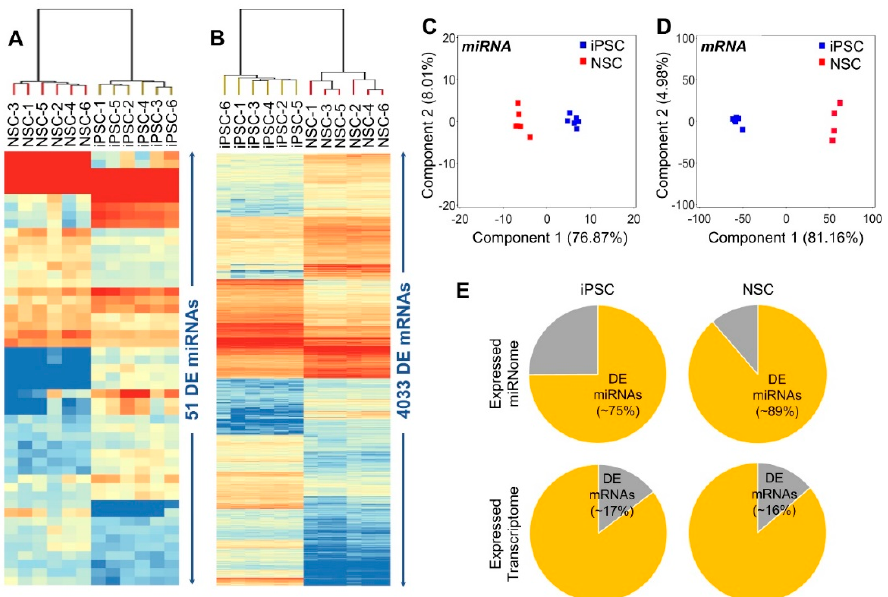
Figure 3. miRNA and mRNA differential expression analysis between iPSCs and their differentiated NSCs. ( A ) Heat map of 51 differentially expressed (DE) miRNAs. ( B ) Heat map of 4033 DE mRNAs. ( C , D ) Principal component analysis (PCA) based on DE miRNAs and DE mRNAs between iPSCs and differentiated NSCs. ( E ) Pie graph showing the proportion of DE vs. total expressed miRNome and transcriptome in iPSCs and their differentiated NSCs.